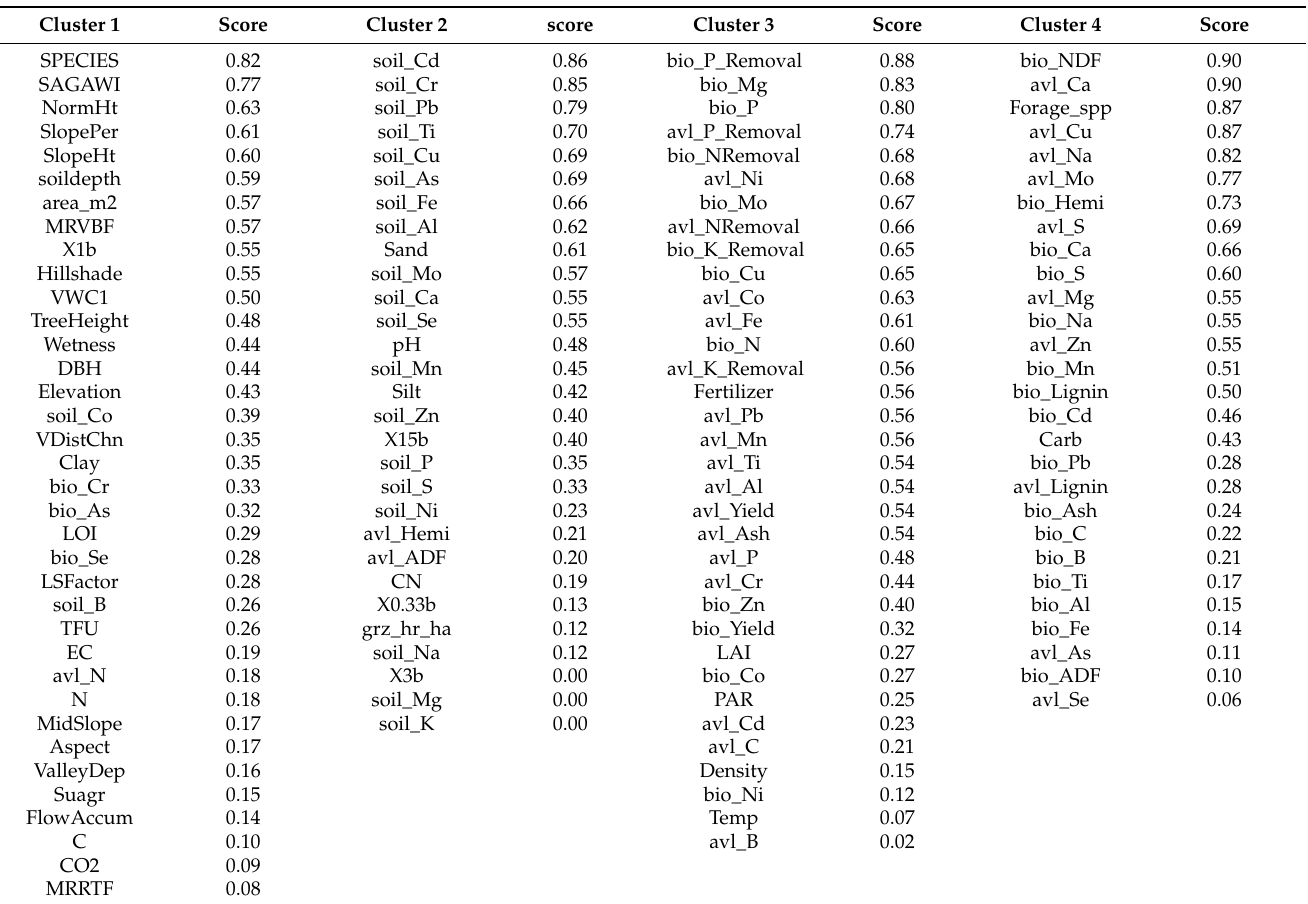
Figure 2. A flow chart of the model building steps used in this study. Each shaded box shows the comparison of two approaches. Hierarchical variable clustering vs. random forest-based variable rankings approach was compared first. Animal grazing preference was then modeled (multiple linear regression vs. classification and regression tree) using the variables selected from the variable rankings method. Table 1. Variables † selected per cluster using hierarchical clustering methods. Four clusters were decided based on dendrogram visualization. A total of 130 (5 categorical + 125 numerical) variables were classified into one of four clusters. The score is the squared loadings described in [27], and the value indicates how strongly each variable is associated with the